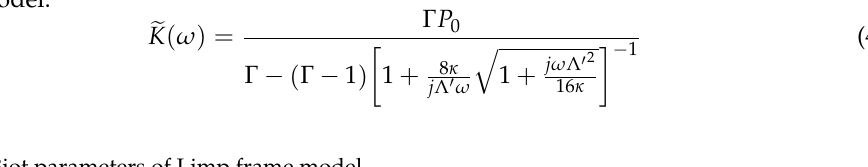
Table 2. Biot parameters of Limp frame